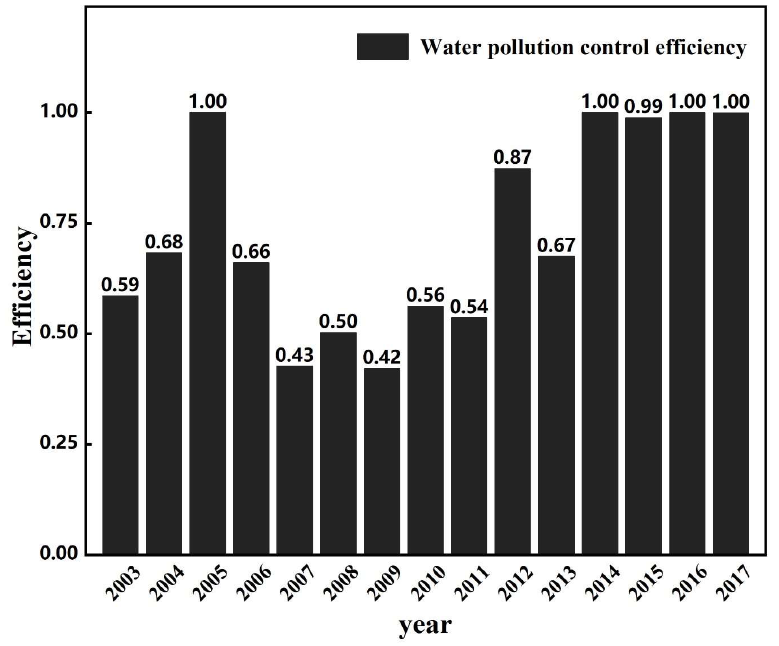
Figure 4. Water pollution control efficiency in Chengde city from 2003 to 2017.